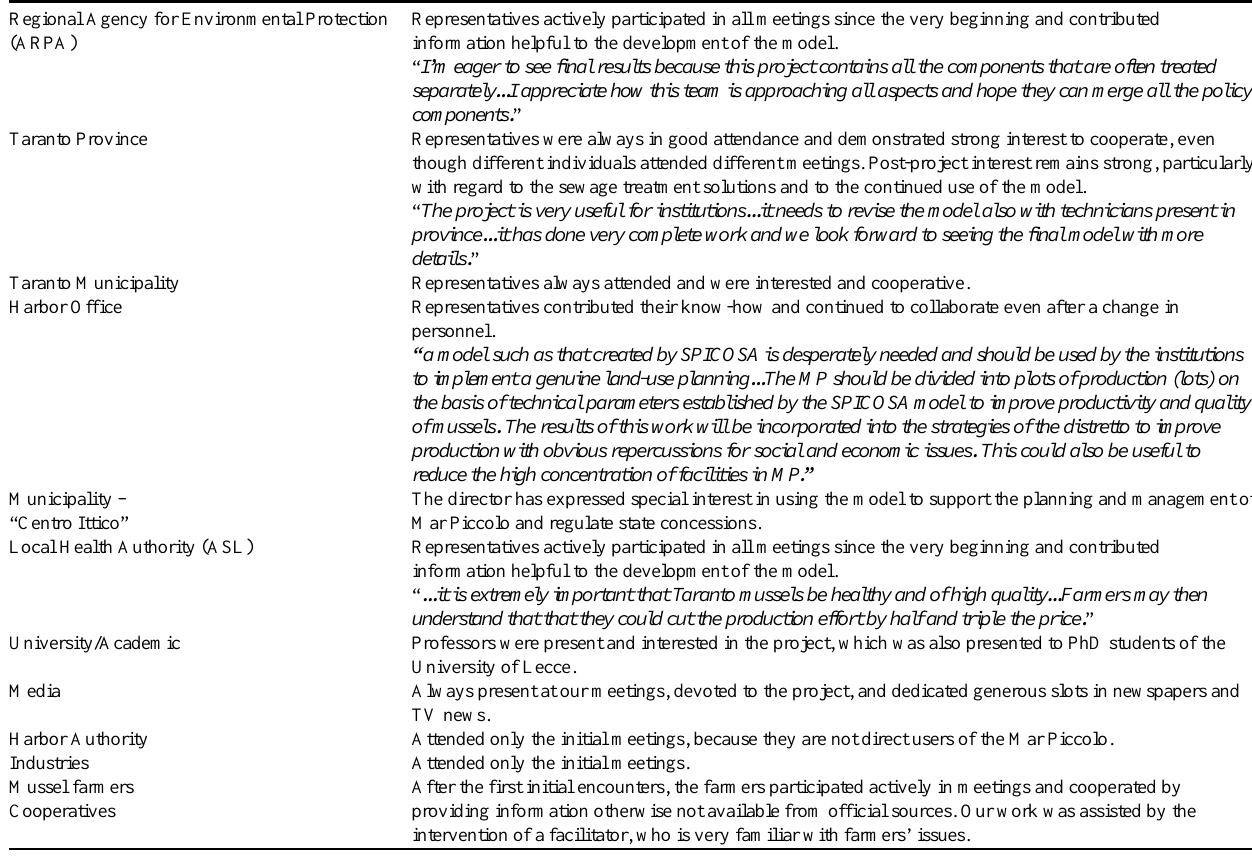
Table 7 . Stakeholder involvement and some opinions.